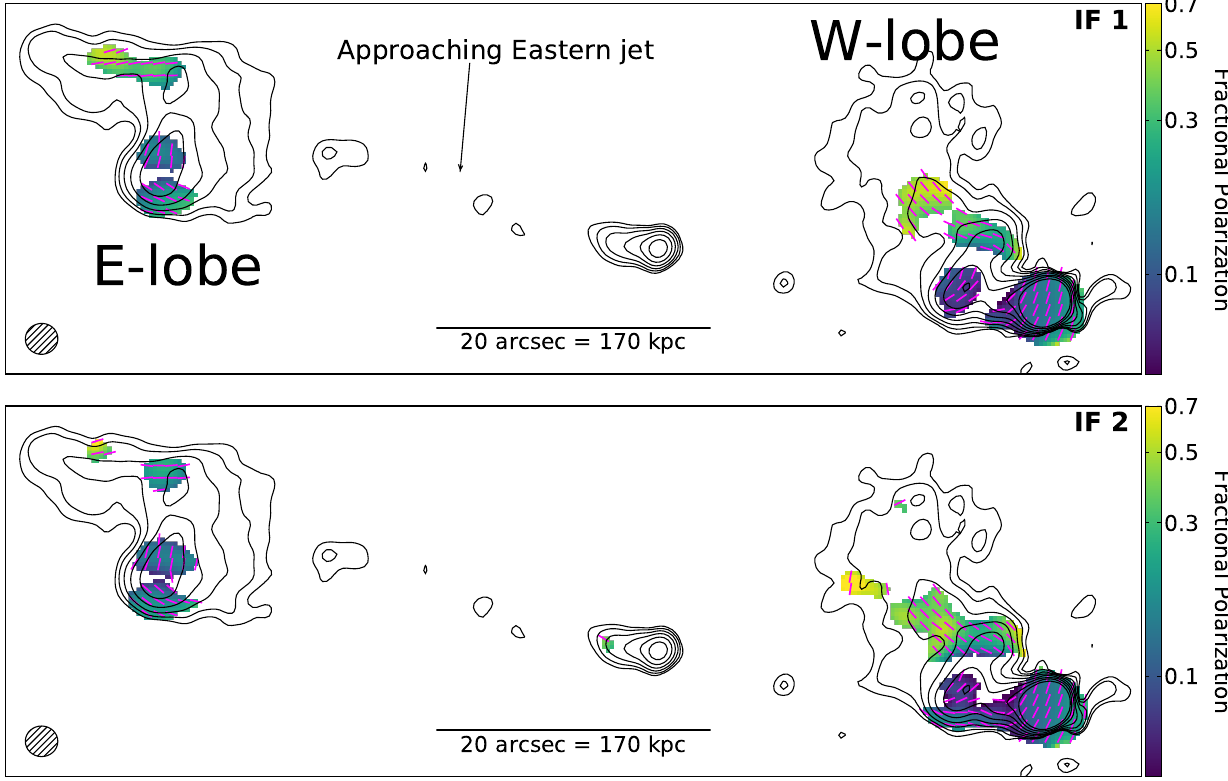
Figure 2. Fractional polarization images of the FRII HzRG in the two 42-MHz-wide IFs: IF1 (1365 MHz, top ) and IF2 (1435 MHz, bottom ), blanked at the 3 σ level. The black contours indicate the total intensity emission of the high-resolution, √ full-band image, starting at the ∼ 3 σ level emission and increasing with a 3 geometric progression. The magenta dashes indicate the orientation of the magnetic field. The dashed ellipse in the bottom-left corner represents the restoring beam. The solid black line in the bottom is the angular and physical scale. For clarity, in the IF1 image we indicated the Eastern and Western lobes as E-lobe and W-lobe, respectively, and specify that the Eastern jet is the approaching